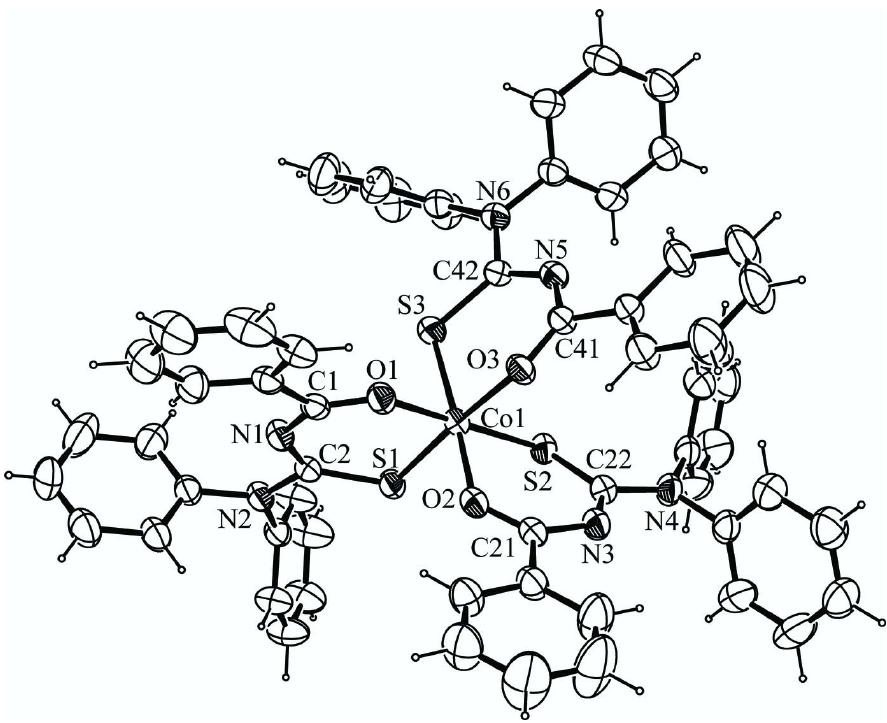
Figure 1 The molecular structure of the title compound. Displacement ellipsoids are drawn at the 50% probability level.